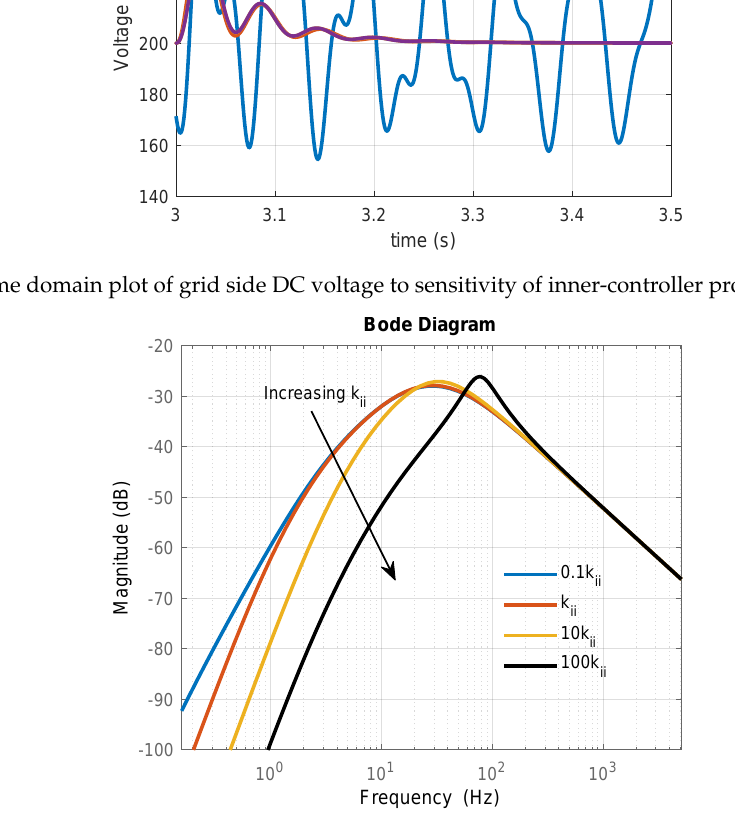
Figure 19. Sensitivity of output admittance Y oc , v to k ii in increasing order of 0.1 × , 1 × , 10 × , and 100 × k ii (base case).